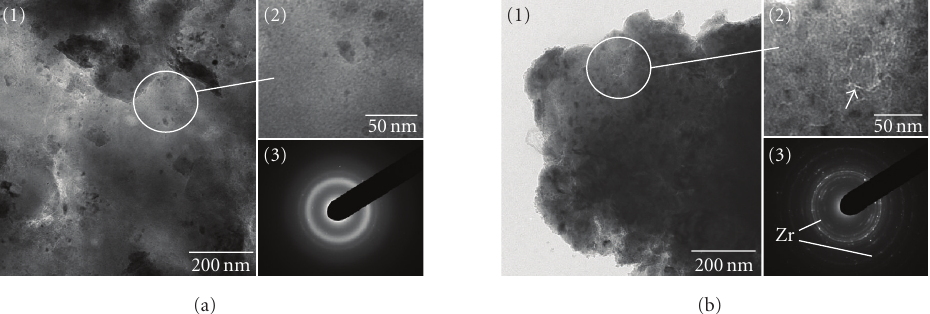
Figure 3: (a) TEM observation of as-sputtered Zr-Cu film with 34 at% Cu, and (b) annealed at 723 K in argon gas atmosphere.